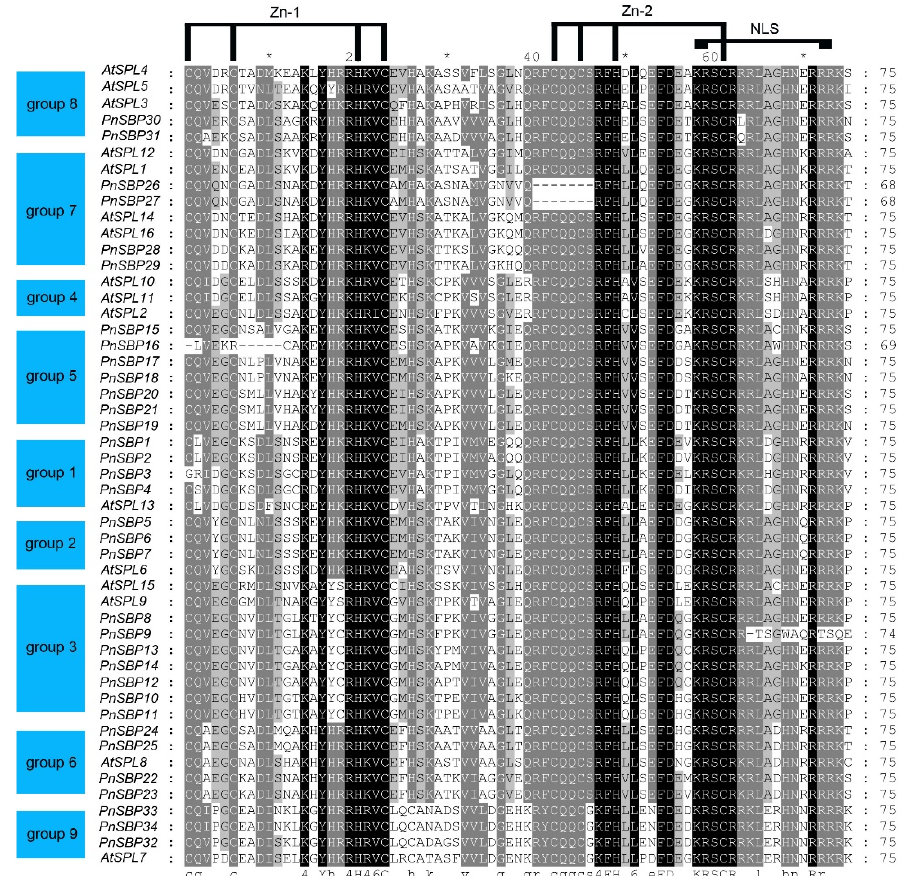
Figure 2. The multiple alignment of SBP-specific domain. Zn-1, Zn-2, and NLS are highlighted on the top.